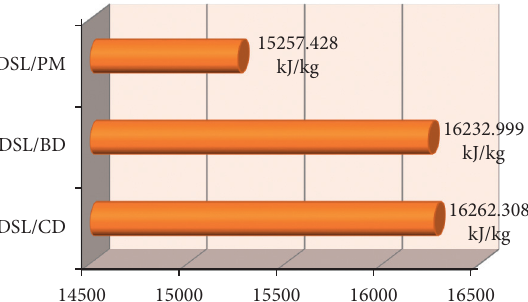
Figure 12: GCV of the briquettes with different